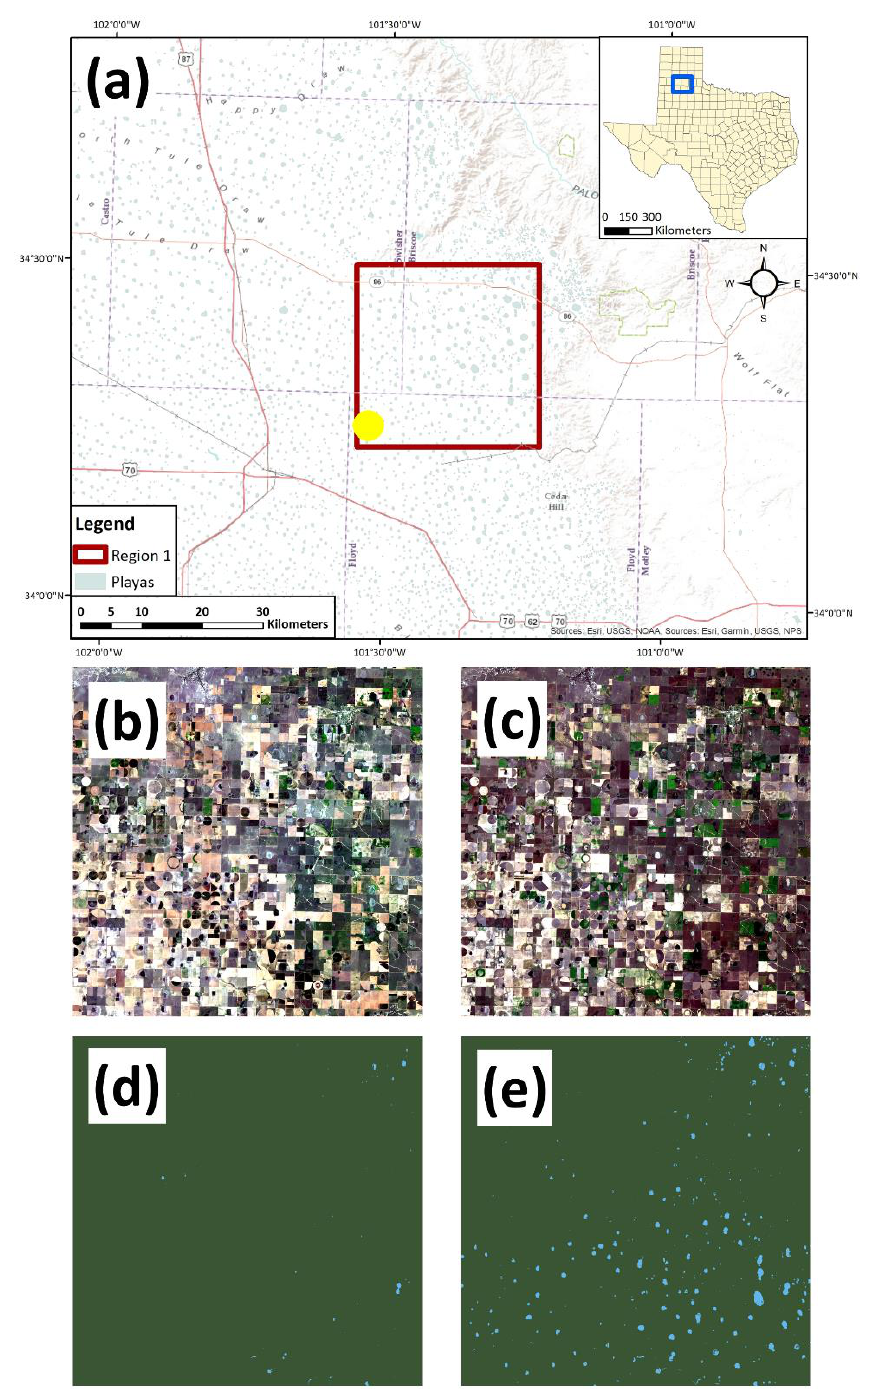
Figure 1. ( a ). Map of 30 km by 30 km study area (shown in brown square) in West Texas, USA (upper right inset). True color imagery of the study area for ( b ) 25 September 2018 and ( c ) 28 October 2018. The corresponding classified water surface area (water represented by blue colored areas, while all non-water surfaces are represented by green colored areas) for ( d ) 25 September 2018 and ( e ) 28 October 2018. The yellow dot in ( a ) represents the area shown in Figure